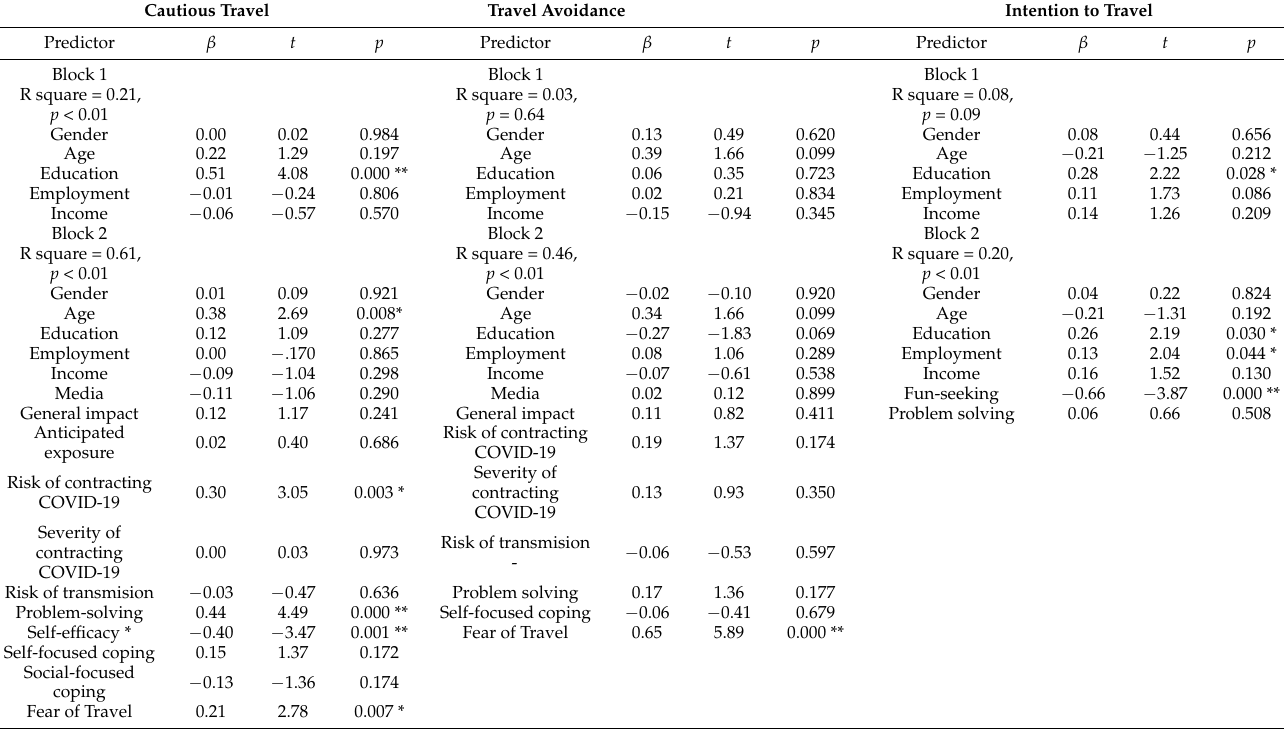
Table 3. Regression coefficients of predictors of cautious travel, travel avoidance, and intention to travel. Cautious Travel Predictor Block 1 R square =